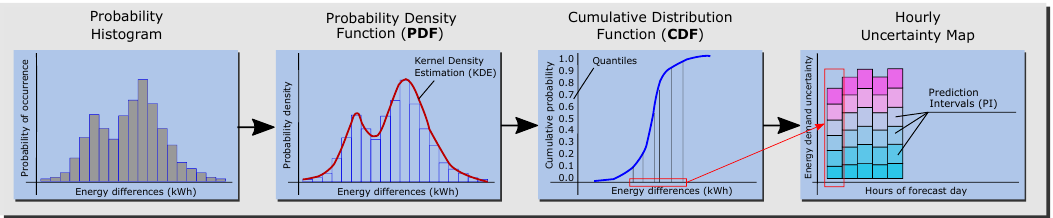
Figure 4. Process of the probabilistic load